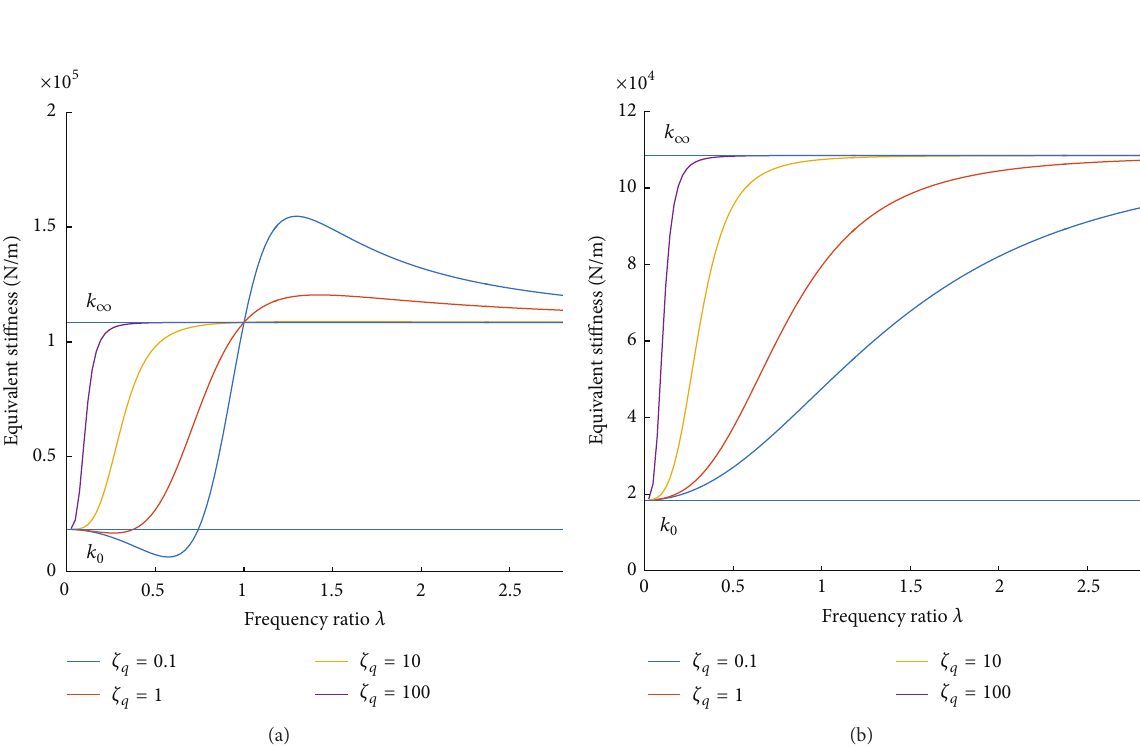
̸= 0 . (b) Numerical simulations of the equivalent stiffness when eq